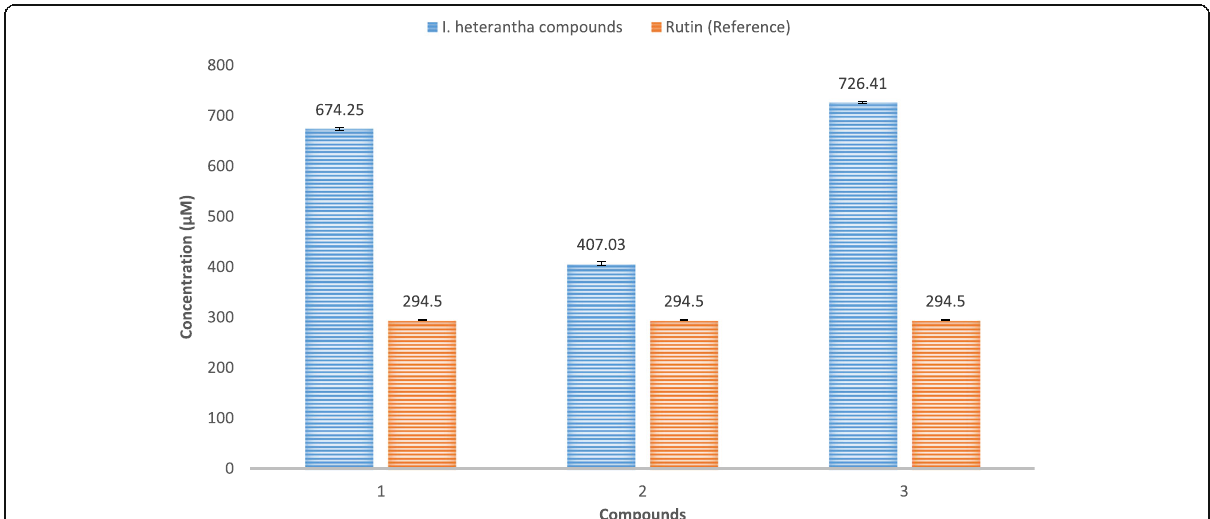
Fig. 4 Comparison of in-vitro antiglycation activity of I. heterantha compounds with reference compound (rutin). Number of sample treatment (N) = 3. The results were expressed as mean ±